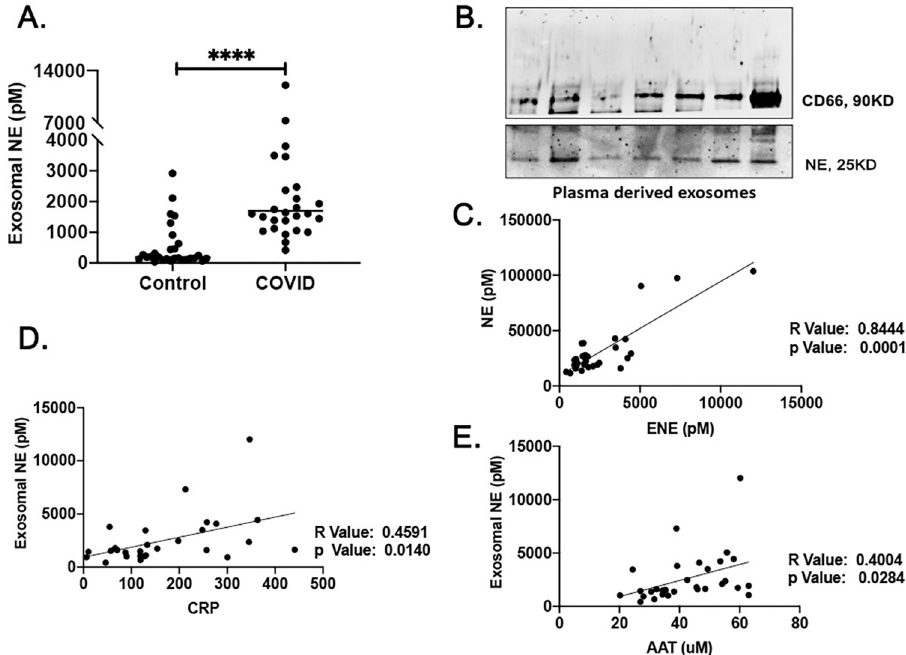
Fig 3. Plasma levels of exosome associated neutrophil elastase (NE) in SARS-CoV2 patients. (A) Higher plasma levels of exosome associated NE in SARS-CoV2 patients compared with healthy controls. (B) The association between exosome associated NE and plasma exosome associated levels of CD66 in SARS-CoV2 patients assessed by western blot analysis. (C) The correlation of the plasma levels of exosome associated NE in SARS-CoV2 patients with levels of free NE. (D) The correlation of the plasma levels of exosome associated NE in SARS-CoV2 patients with levels of CRP, (D) and AAT, ���� p < 0.0001 (two-tailed Mann-Whitney U test, Pearson correlation coefficients).